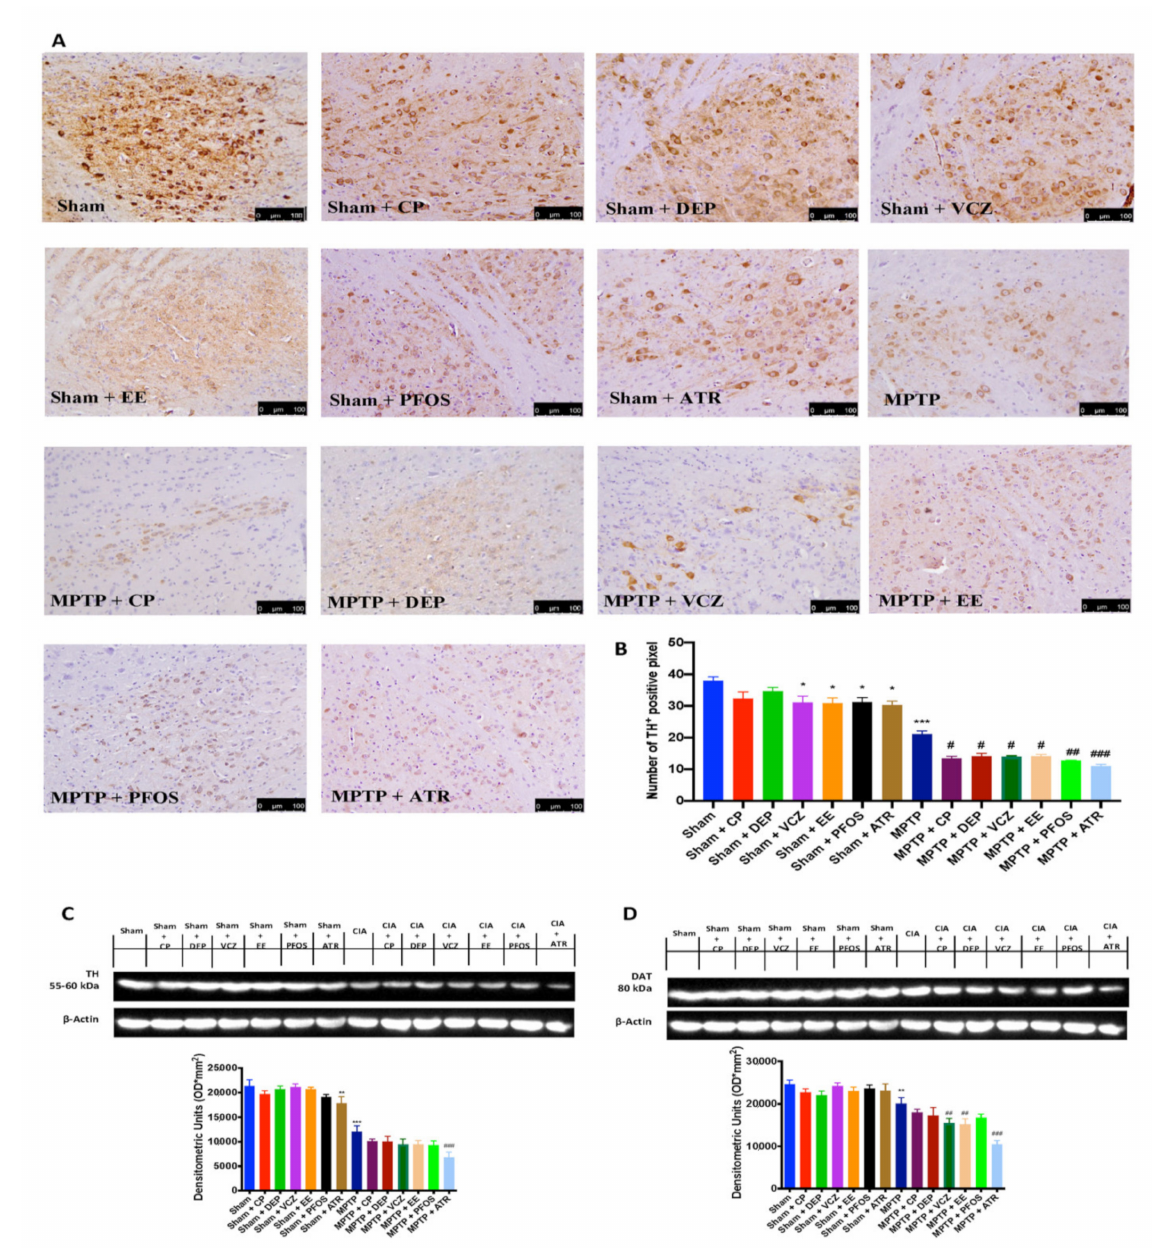
Figure 2. Immunohistochemical evaluation in the midbrain for TH expression ( A ). Graphical quan- tification of TH expression ( B ). Western blots and densitometric analysis of TH ( C ) and DAT ( D ). A 20 × magnification is shown (100- µ m scale bar). A demonstrative blot of lysates with a densitometric analysis for all animals is shown. Data are expressed as the mean ± SEM of N = 6 mice/group. * p < 0.05 vs. sham; ** p < 0.01 vs. sham; *** p < 0.001 vs. sham; # p < 0.05 vs. MPTP; ## p < 0.01 vs. MPTP; ### p < 0.001 vs.